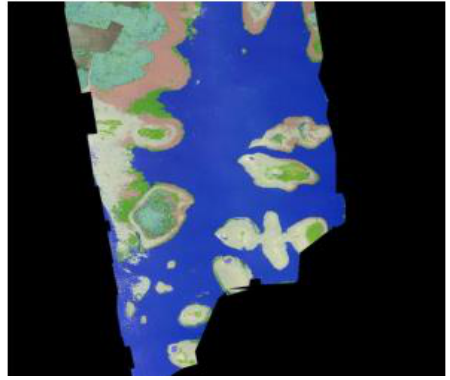
Figure 13. Blk66L005L (Overall Accuracy: 98 %, KIA: 97.2 %)